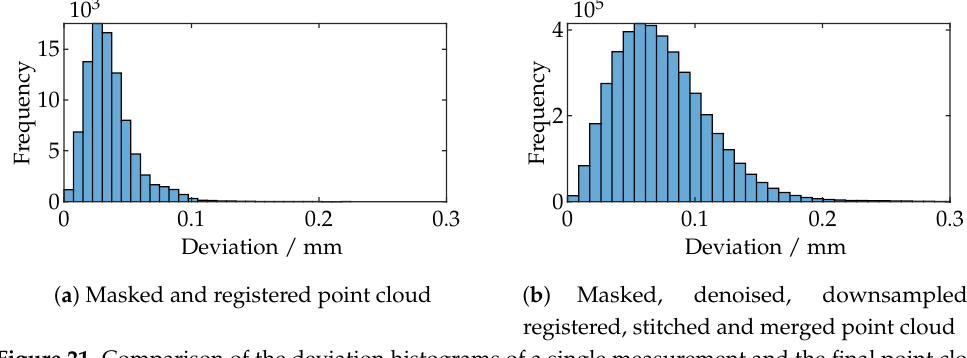
Figure 21. Comparison of the deviation histograms of a single measurement and the final point cloud of all 588